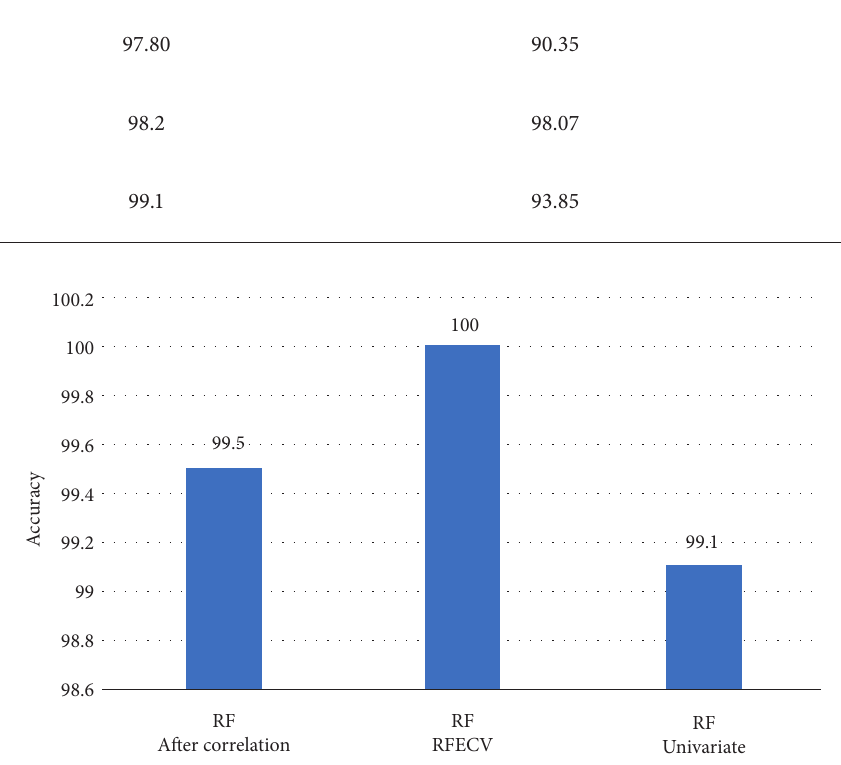
Figure 5: The best models of cross-validation